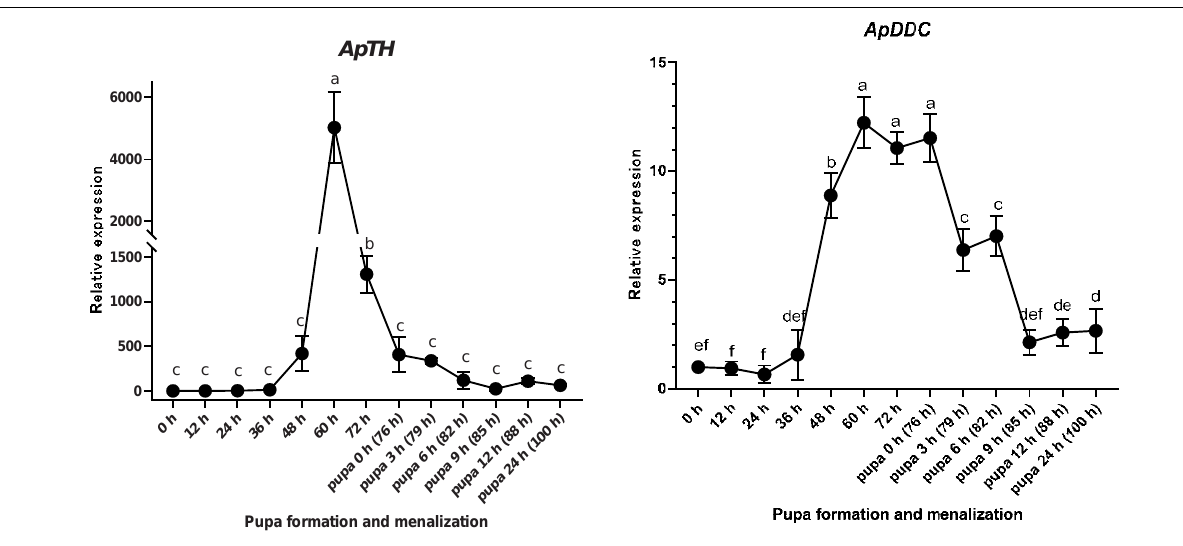
FIGURE 5 | Relative expression levels of ApTH and ApDDC in the epidermis of Antheraea pernyi during the larva–pupa stage, determined by qPCR. Three replicates were considered; the bar represents mean ± SD ( n = 3), and bars annotated with the same lower-case letters are not significant difference by Duncan’s multiple range test ( p <